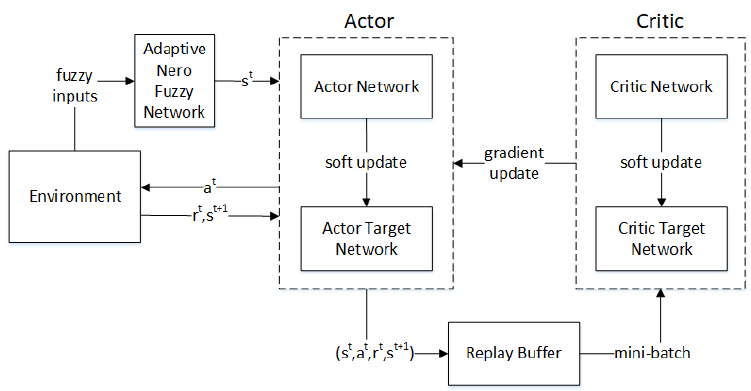
Figure 3. The fuzzy deep deterministic policy gradient training